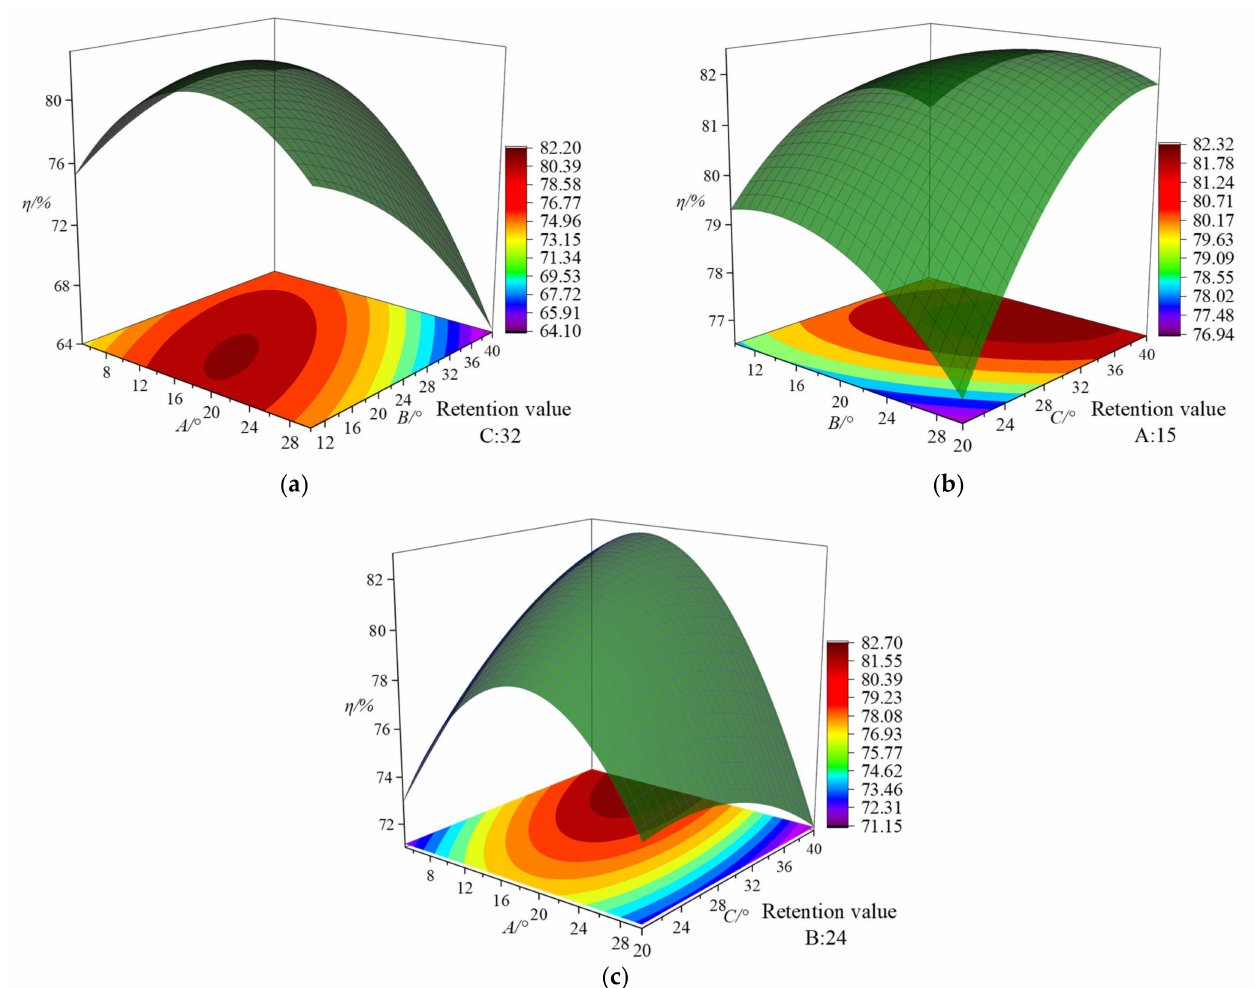
Figure 7. Contour plots and response surface plots of the interaction terms of efficiency and variables. ( a ) Contour plots and response surface plots of efficiency and A, B. ( b ) Contour plots and response surface plots of efficiency and B, C. ( c ) Contour plots and response surface plots of efficiency and A,